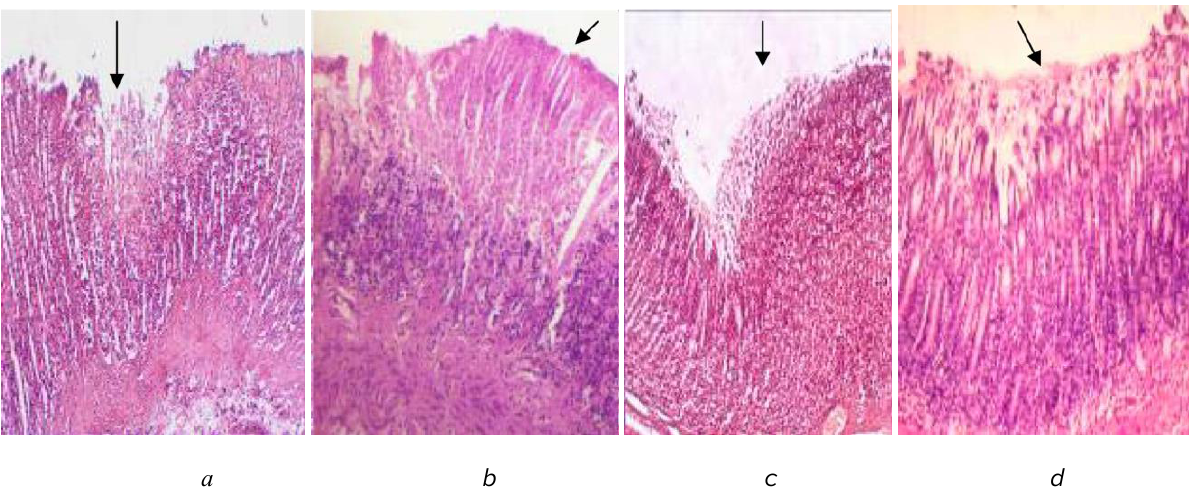
а b c d Fig. 4. The stomach of rats, which were introduced alcohol-prednisolone mixture. Ulcerative defect in: a – fundal; b – pyloric parts, surface erosion with necrobiosis of integumentary and dimpled cells in the: c – prepyloric; d –